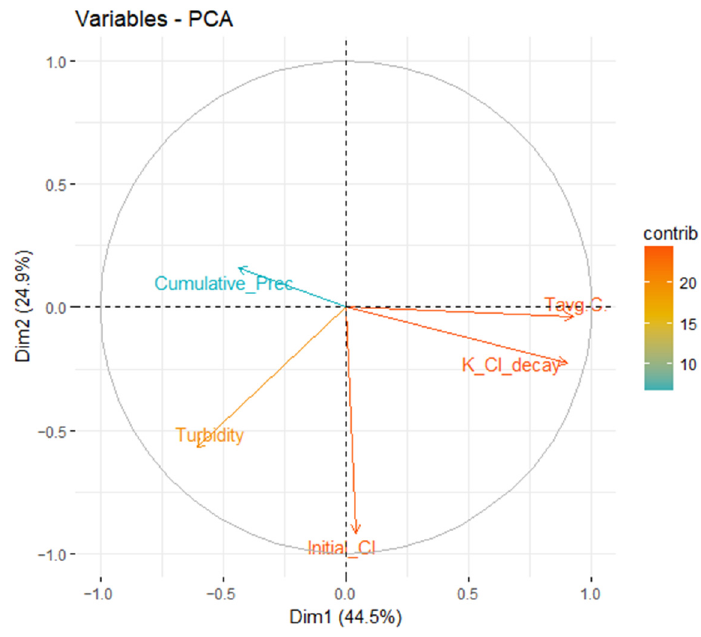
Figure 9. Variables for the two main dimensions of the PCA.